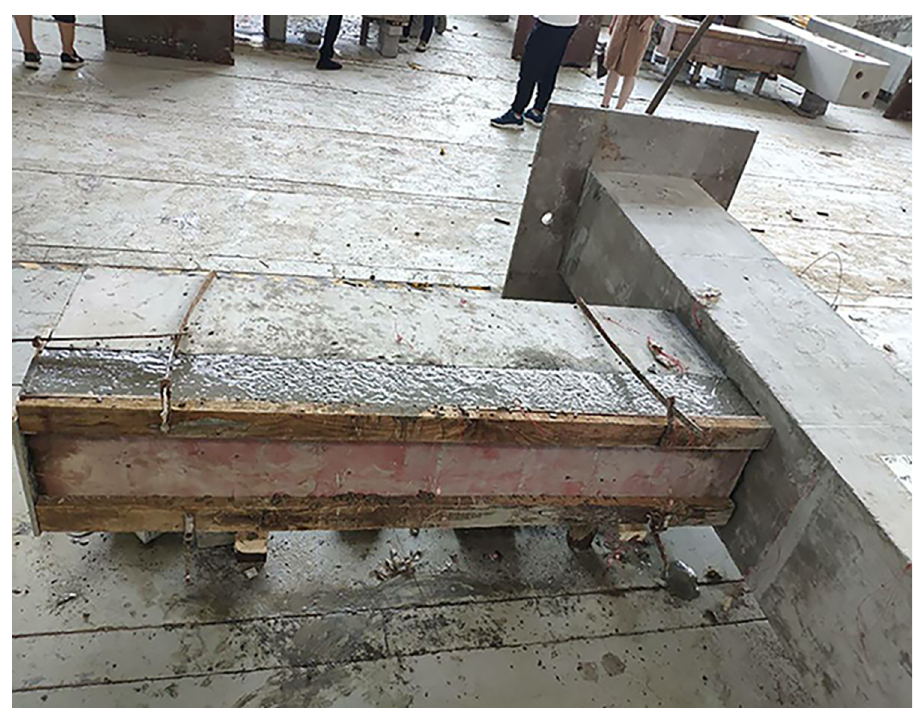
Fig 6. Pouring concrete.